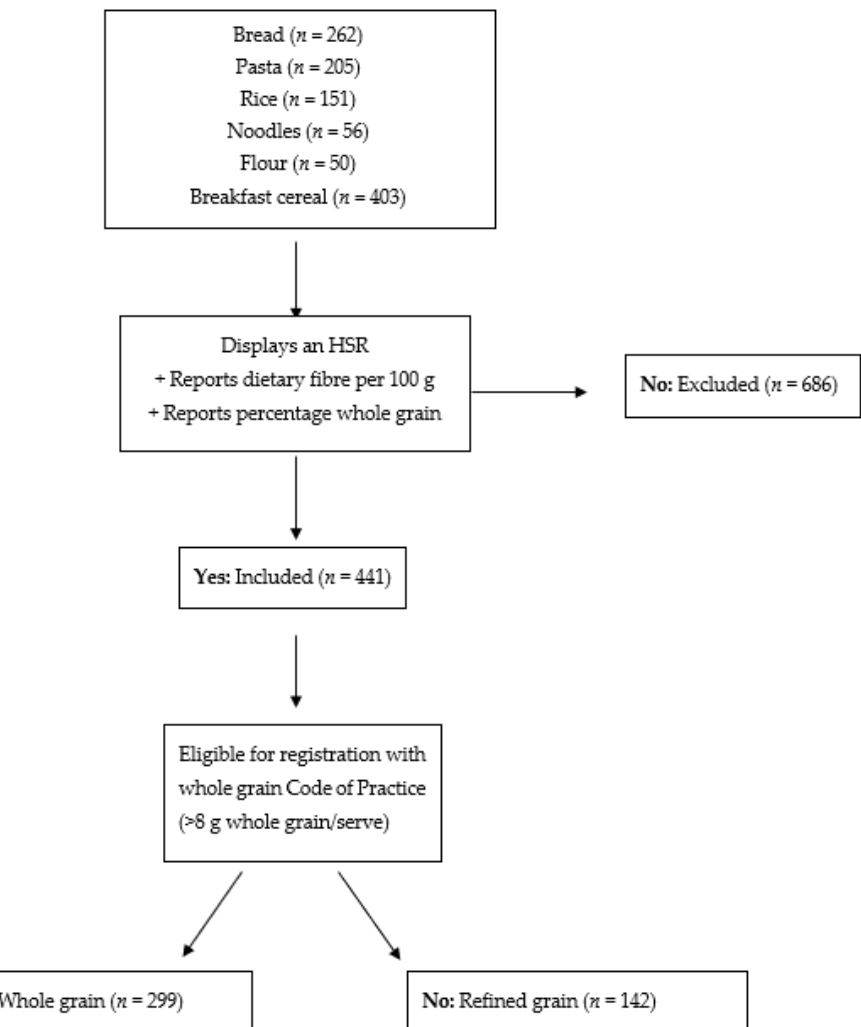
Figure 1. Exclusion criteria for final grain foods sample. HSR: Health Star Rating.